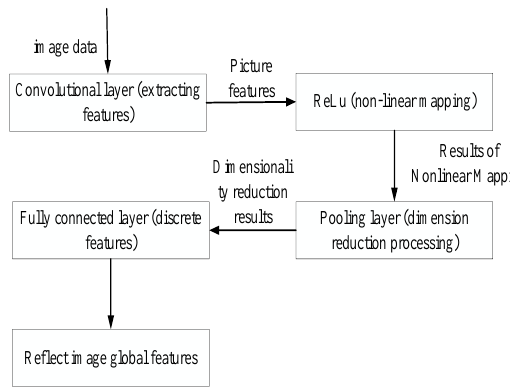
Figure 7 . ResNet working principle diagram.